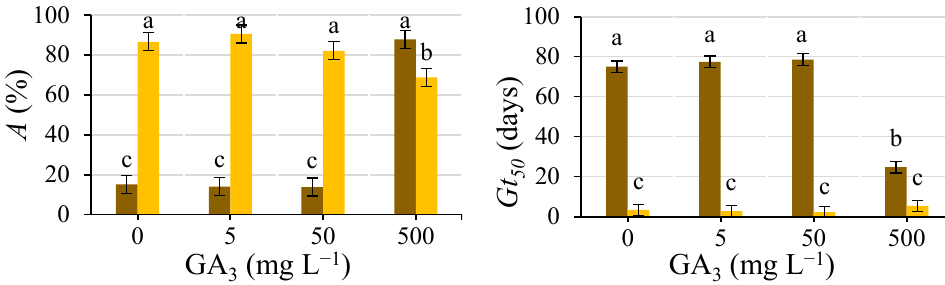
Figure 6. Analysis of the significant interactions of the analysis of variance in Table 2 between the presence of the testa (with testa (brown) and without testa (yellow)) and the concentration of the GA 3 solution used to wet the substrate (0, 5, 50 and 500 mg L −1 ) on A and Gt 50 . Average values of four replicates. Different letters indicate significant differences according to the LSD test. Error bars represent the LSD ( p ≤ 0.05).